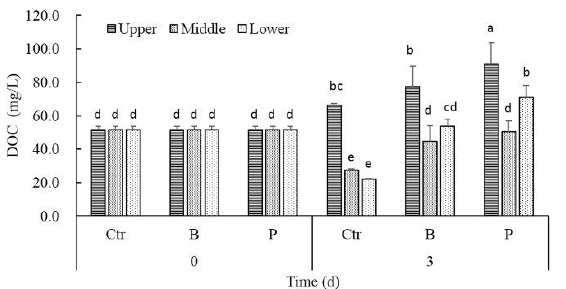
Figure 5. The effect of algicidal and denitrifying bacteria on DOC concentrations in the different layers of water.